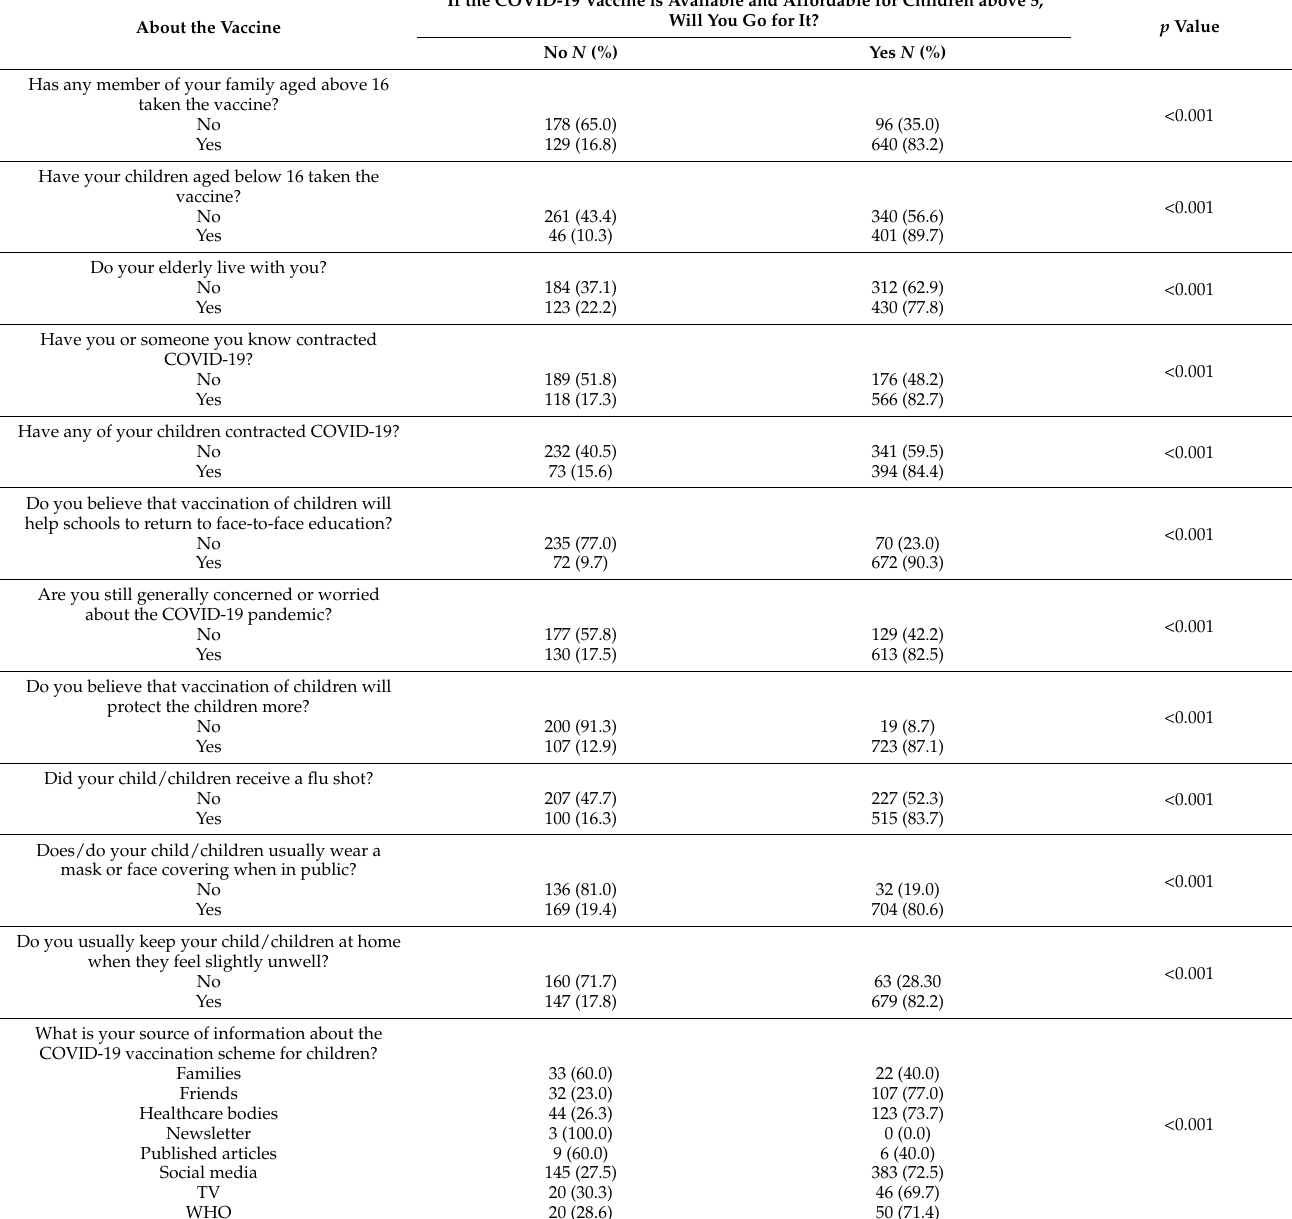
Table 4. Association between parents’ perception towards COVID-19 vaccine and parents’ acceptance of the COVID-19 vaccine ( n =